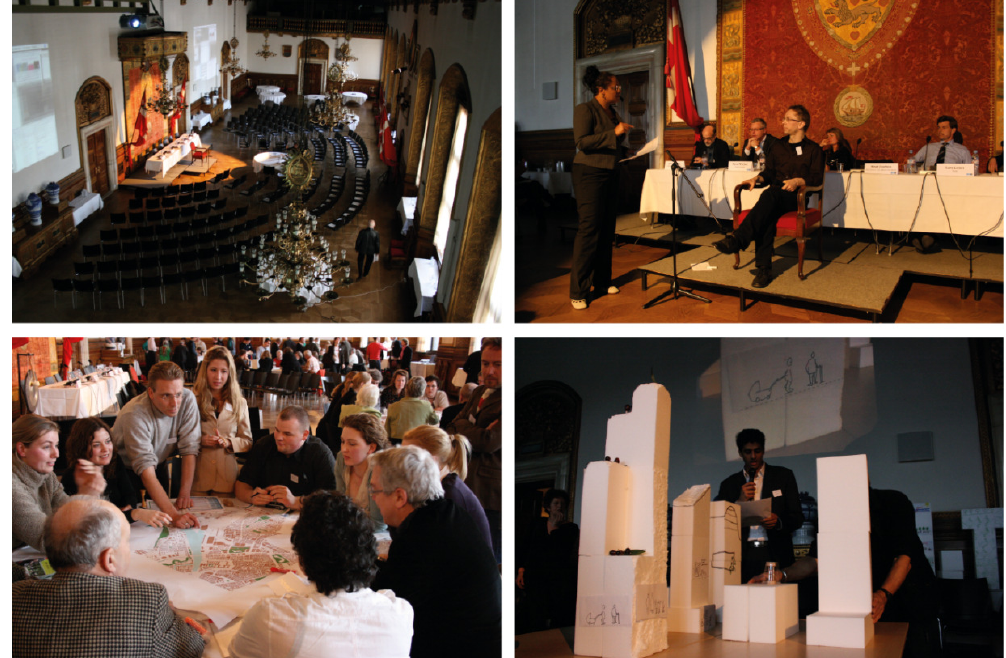
Figure 5. Elements of the hearing on the high‐rise strategy. From left to right, top to bottom: Trial scenography, “cross‐ examination,” “jury deliberation,” and “verdict.” Source: Courtesy of